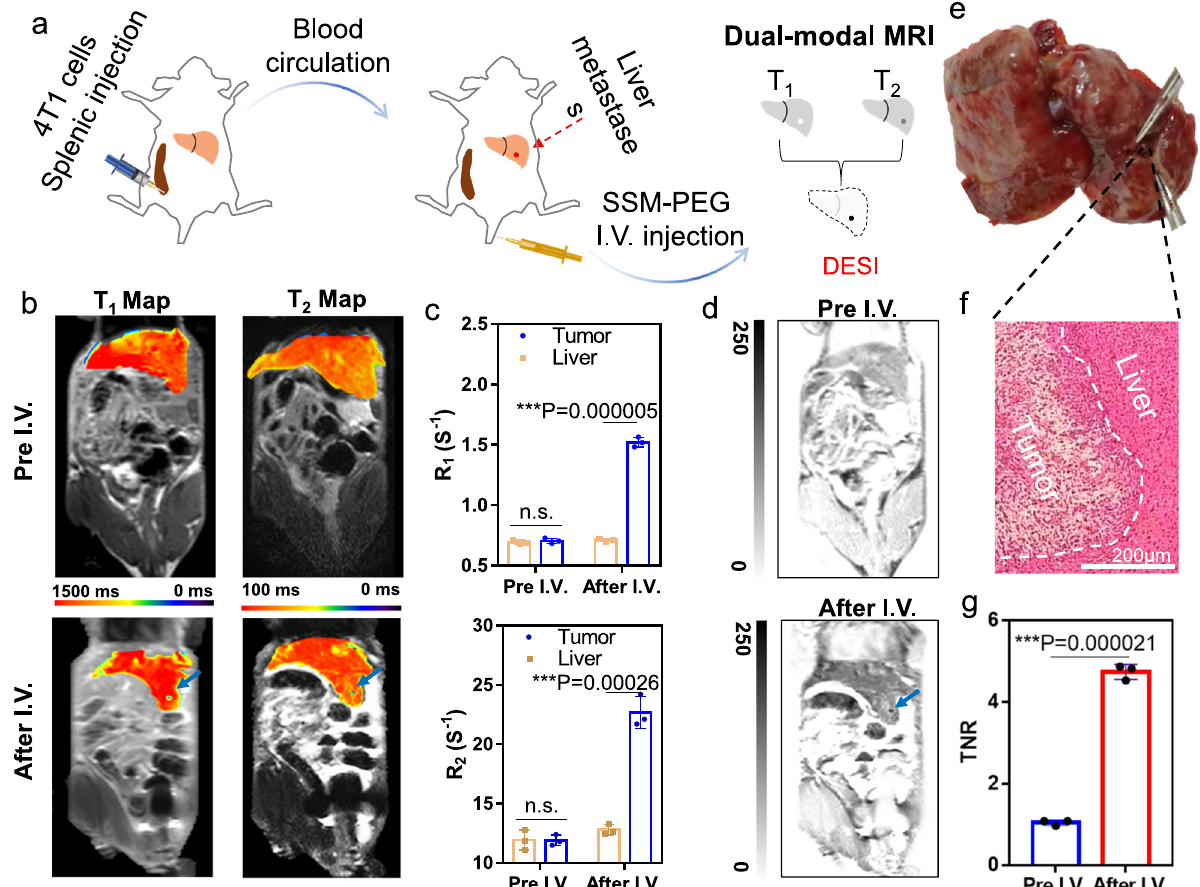
Fig. 6 | SSM-PEG (PEG-modi fi ed SPIO@SiO 2 @MnO 2 ) for MRI trace of tiny liver metastasesin vivo.a Illustrationof the constructionand MRI diagnosisprocesses of the metastatic model. b T 1 and T 2 map images and c R 1 and R 2 at the liver metastasisofthemicebeforeI.V.injectionand2haftertheinjectionofSSM-PEG.T 1 and T 2 Map are representative data from three mice samples. R 1 and R 2 Data are presented as mean±SD from three independent mice samples. d T 1 and T 2 dual- modal MRI images of the liver metastasis were processed by DESI method, which weretakenwithouttheuseofcontrastagentand2haftertheinjectionofSSM-PEG.